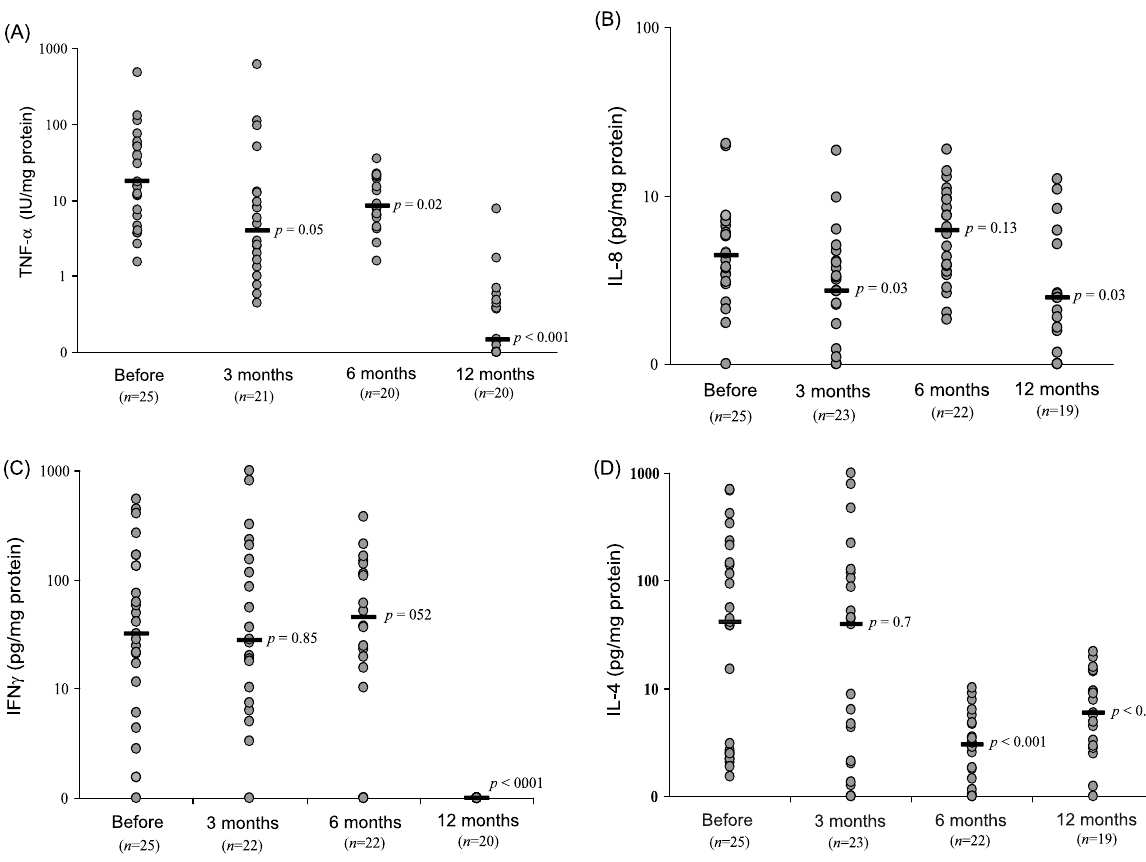
Table 2. Neutrophil elastase activity and protein concentration in the sputa of cystic fibrosis patients during clarithromycin treatment